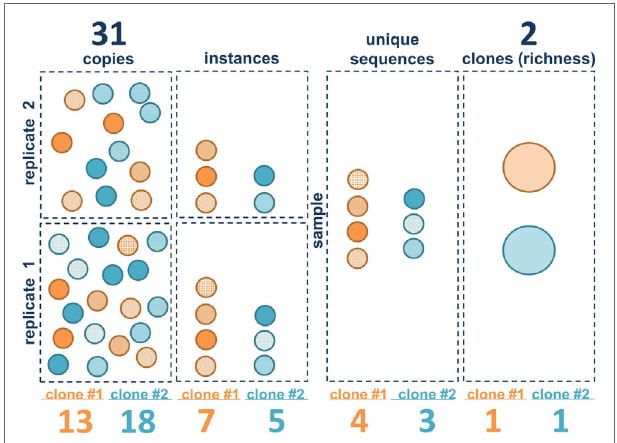
FIgUrE 2 | Clone size measure definitions. The first three vertical panels represent the three measures of clone size in this paper: copies, instances, and unique sequences. Each circle represents a B cell. Sequence variants within clone 1 (orange) and clone 2 (blue) are represented by different patterns in the circles. The right panel contains the clones (large ovals). Squares represent within the left two panels represent individual sequencing libraries whereas the entire collection of replicates from a single sample is shown in the right panels. Summed values (for both clones) for each metric are given above. Values for each individual clone are given